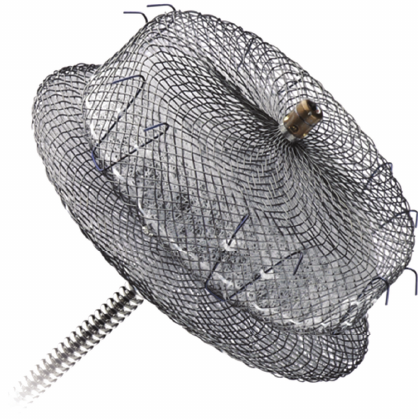
Figure 3: AMPLATZER cardiac plug. (AMPLATZER and St. Jude Medical, Inc. Reprinted with permission of St. Jude Medical, © 2011. All rights reserved).